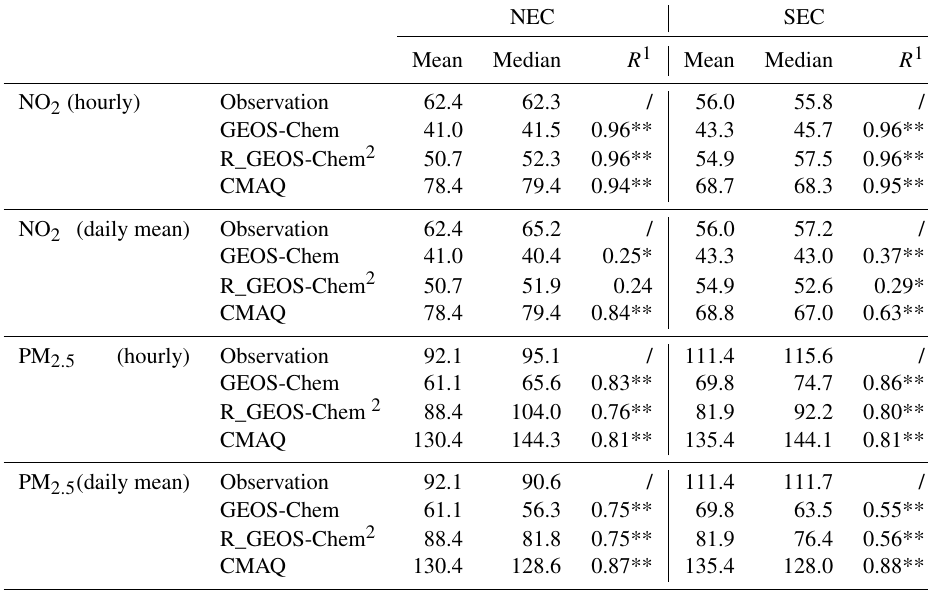
1 Correlation between observed and simulated variables. ** indicates the correlation coefficient is statistically significant with the P value < 0 . 01 , while * indicates it passed a statistical test with the P value < 0 . 01 . 2 Revised GEOS-Chem NO 2 and PM 2 . 5 by multiplying the ratio of the first layer to the second layer of CMAQ values.